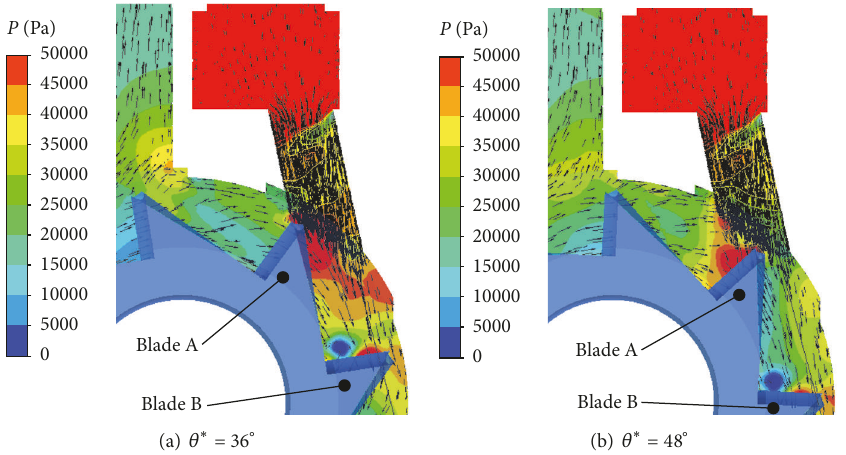
Figure 22: Static pressure distributions and absolute velocity vectors ( 𝑛 = 400 ,000 min −1